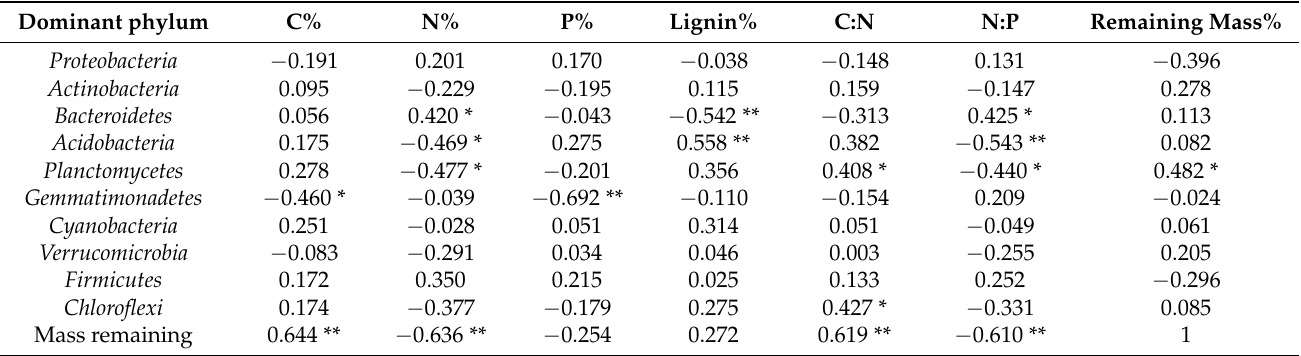
Table 5. Correlation analysis among the top 10 dominant bacterial phyla, the remaining mass and the initial litter chemistry.